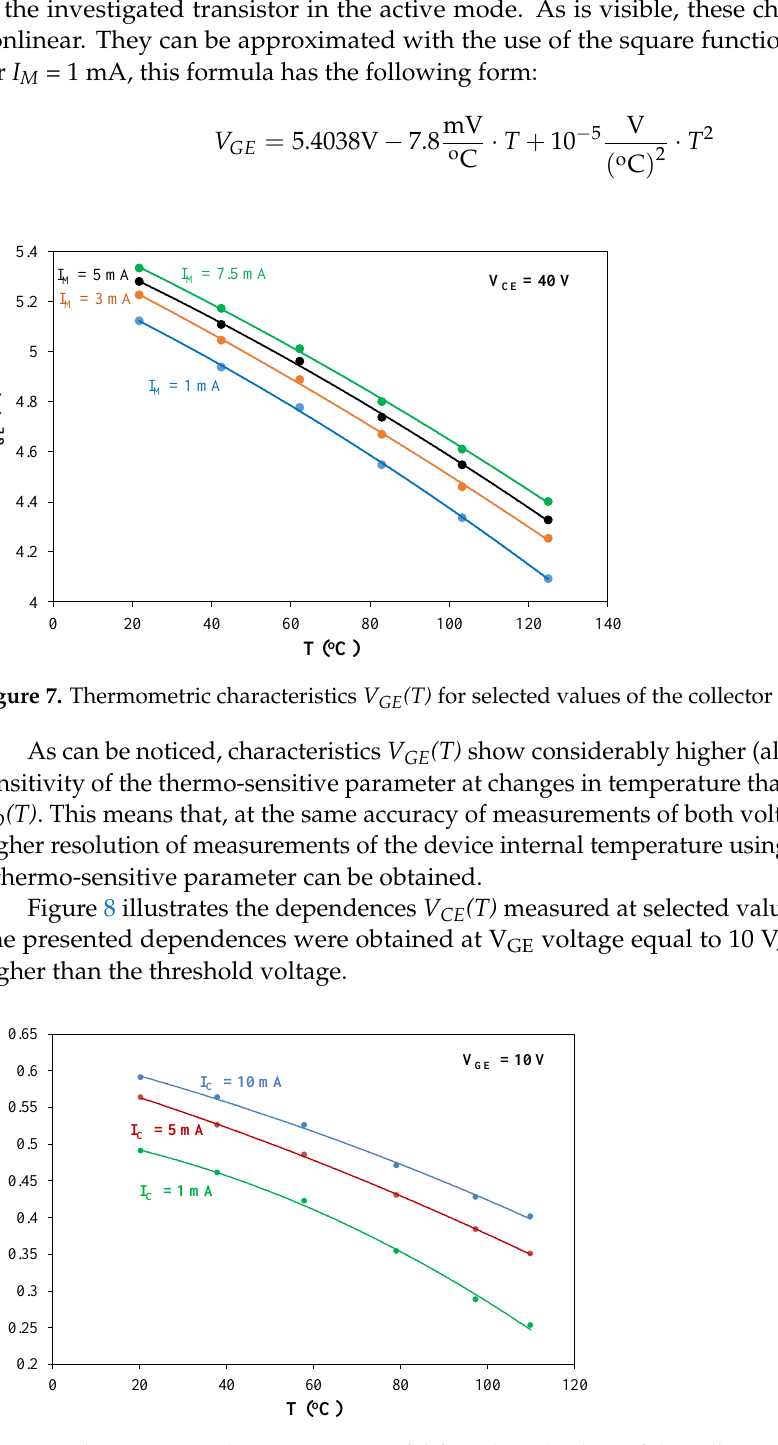
Figure 8. Thermometric characteristics V CE (T) for selected values of the collector current. As is visible, the dependences V CE (T) are nonlinear for low values of the collector current ( I C = 1 mA) and nearly linear for much higher values of this current. The average value of the slope of these dependences belongs to the range from − 2.11 mV/K to − 2.67 mV/K. The accuracy of indirect electrical methods of measuring thermal parameters of the IGBT is analysed in [27,34]. Based on the considerations presented in the cited